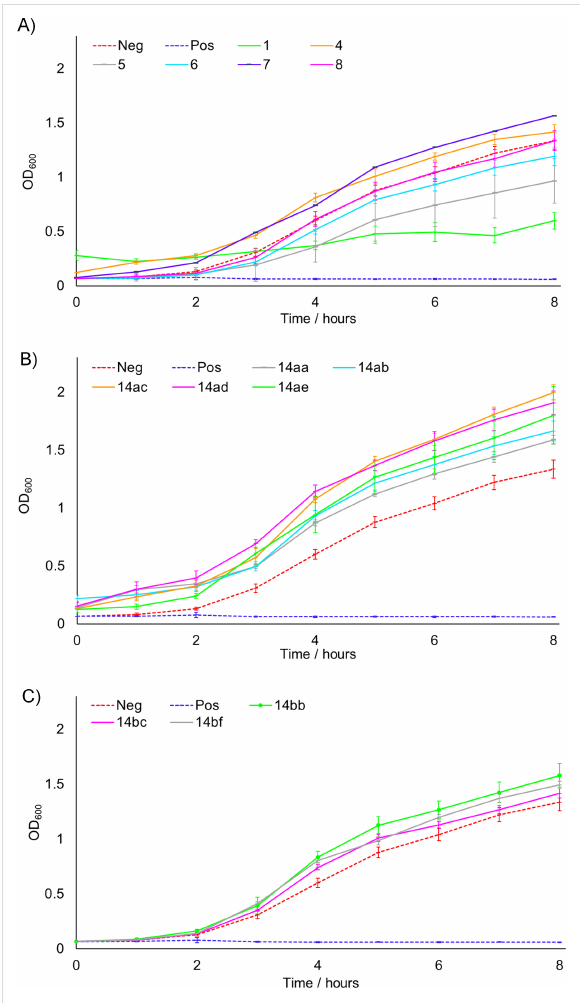
Figure 2: Growth of E. coli ESS with time in the presence of 200 μ M of each compound. A) Natural product series. B) Saturated analogue series. C) Truncated analogue series. Neg = negative control (DMSO blank), Pos = positive control (gentamicin). Experiments were carried